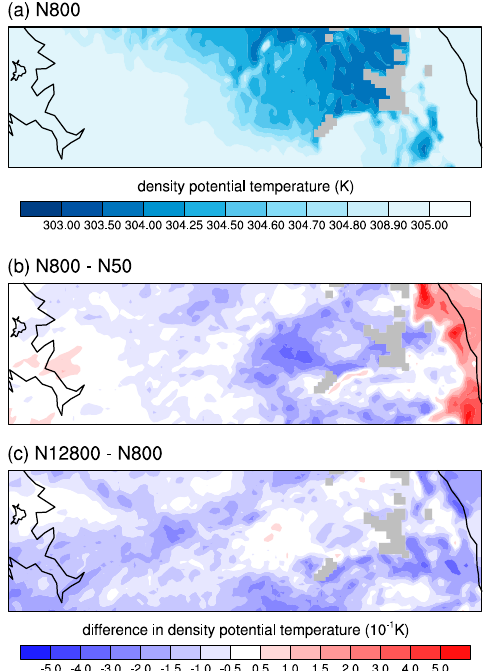
Figure 14. ( a ) Horizontal distribution of density potential temperature ( θ ρ ) at z = 1 km. Horizontal distributions of the differences in θ ρ ( b ) between the N 0 = 800 cm − 3 and N 0 = 50 cm − 3 cases and ( c ) between the N 0 = 12,800 cm − 3 and N 0 = 800 cm − 3 cases. The area with gray represents where the terrain height is higher than z = 1 km.